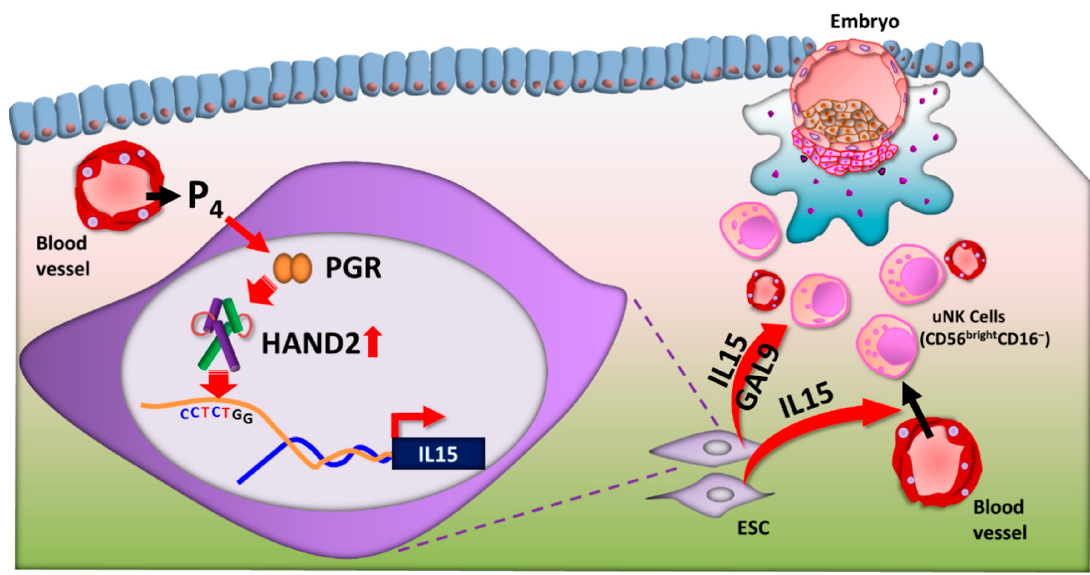
Figure 4. Regulation of uterine natural killer (uNK) cells by heart- and neural crest derivatives-expressed protein 2 (HAND2). After ovulation, progesterone (P4) is secreted from the corpus luteum. In response to increasing P4, endometrial stromal cells (ESCs) differentiate to decidual cells in the secretory phase. P4-binding progesterone receptor (PGR) is recruited to P4-response elements in the promoters of HAND2 and upregulates HAND2 expression. HAND2 directly upregulates IL-15 transcription via the HAND2 motif (CCTCTGG) in the upstream region of the IL-15 gene in ESCs. IL-15 is secreted from ESCs and has a critical role in regulation of the differentiation and function of uNK cells. GAL9, galectin 9.